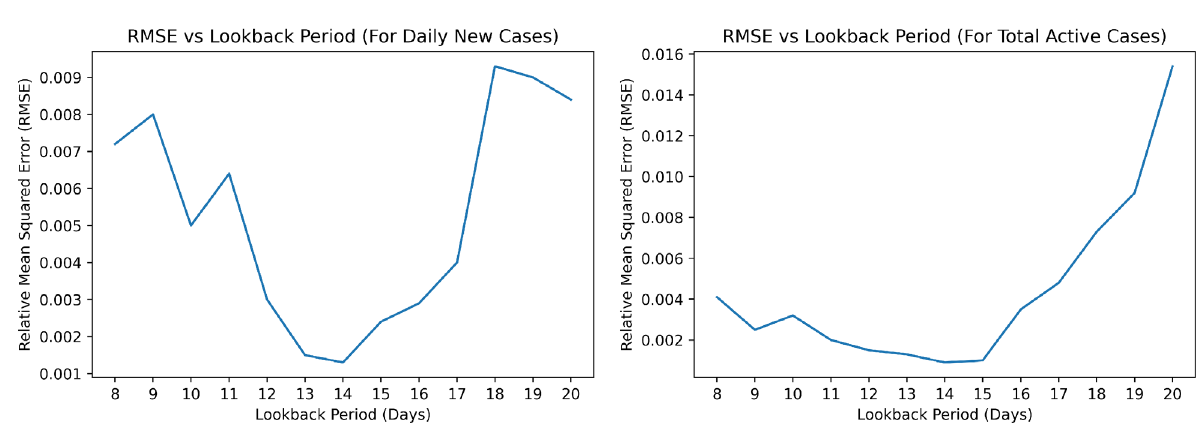
Figure 3. R-MSE and STD over 20 runs for all the models.